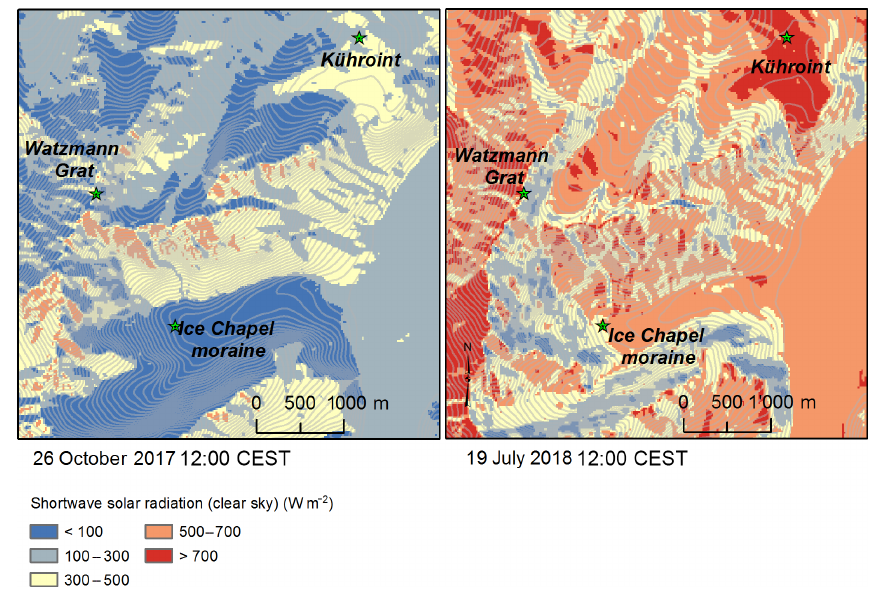
Figure 2. Potential shortwave radiation for 26 October 2017, 12:00 and for 19 July 2018, 12:00.